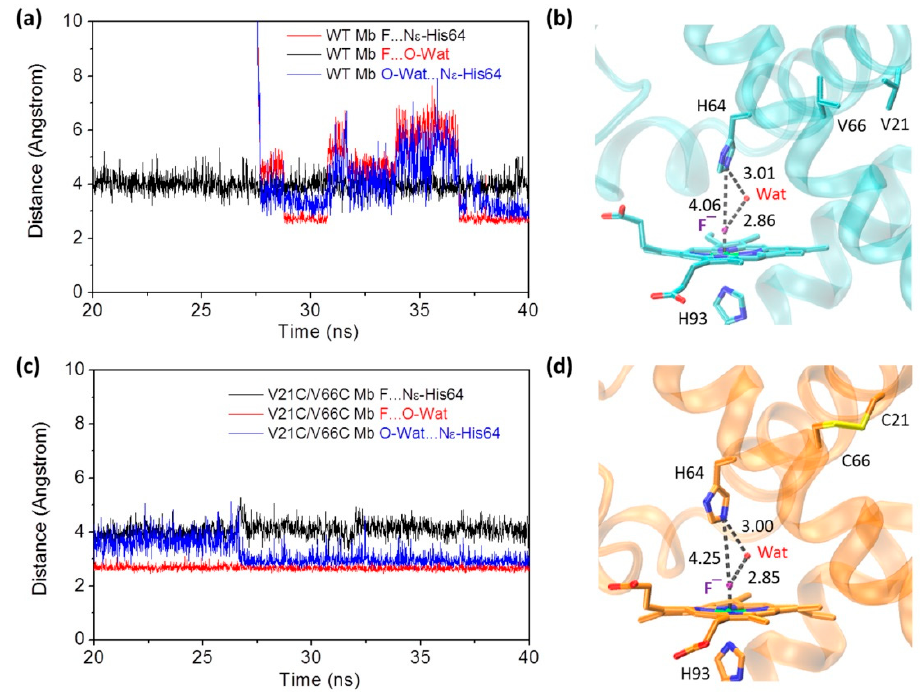
Figure 4. Time-dependence of distances between fluoride ion and the distal His64, fluoride ion and distal water, and distal water and His64, for WT Mb ( a ) and V21C / V66C Mb ( c ), respectively. The modeling structures of WT Mb ( b ) and V21C / V66C Mb ( d ) at the end of simulation. The H-bond interactions in the heme distal site are indicated by dotted lines, as well as the distance (Å).